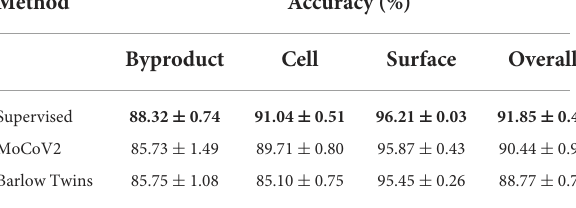
TABLE 2 Classification accuracy percentages under fine-tuning evaluation on Biofilm dataset with all the labeled